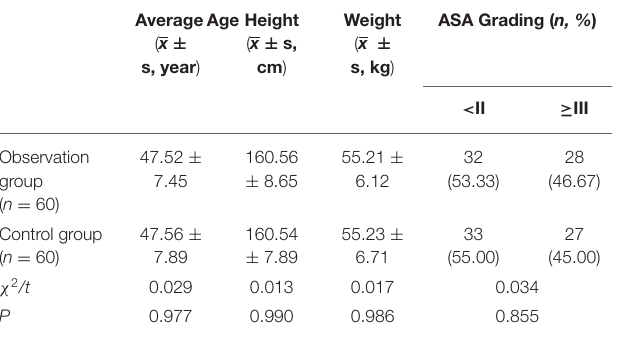
TABLE 1 | General data of